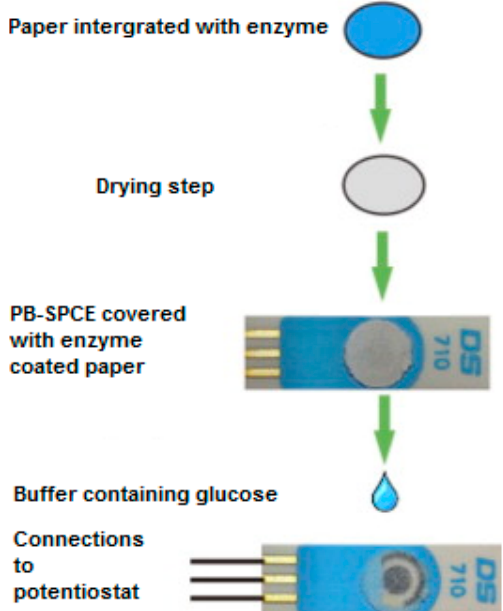
Figure 1. Schematic illustration of glucose oxidase paper disc preparation and integration with the prussian blue-screen-printed carbon electrodes (SPCE). Adapted from [13].